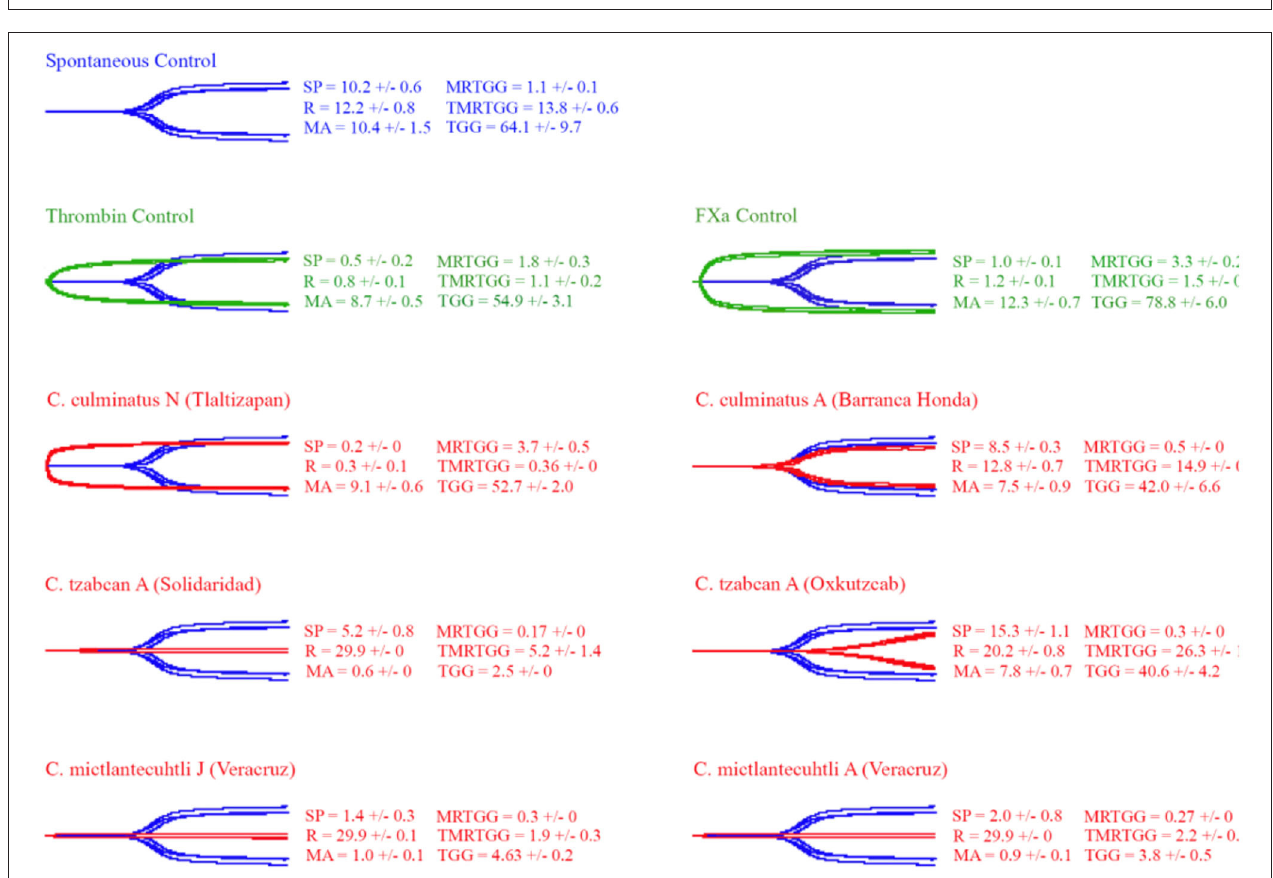
FIGURE 4 | Thromboelastography traces showing the coagulation pattern of human plasma incubated with venoms of six Neotropical rattlesnake respresentatives for neonates (N), juveniles (J), and adults (A). Venom traces are shown in red, spontaneous clotting control traces in blue, thrombin and Fxa control traces in green. SP, split point (min); R, time (min) to minimum detectable clot (2mm): MA, maximum amplitude (mm); MRTGG, maximum rate of thrombus generation (dynes/cm 2 ); TMRTGG, time to maximum thrombus generation (min); TGG, total thrombus generation (dynes/cm 2 ). Results shown as n = 4 mean ± SD.